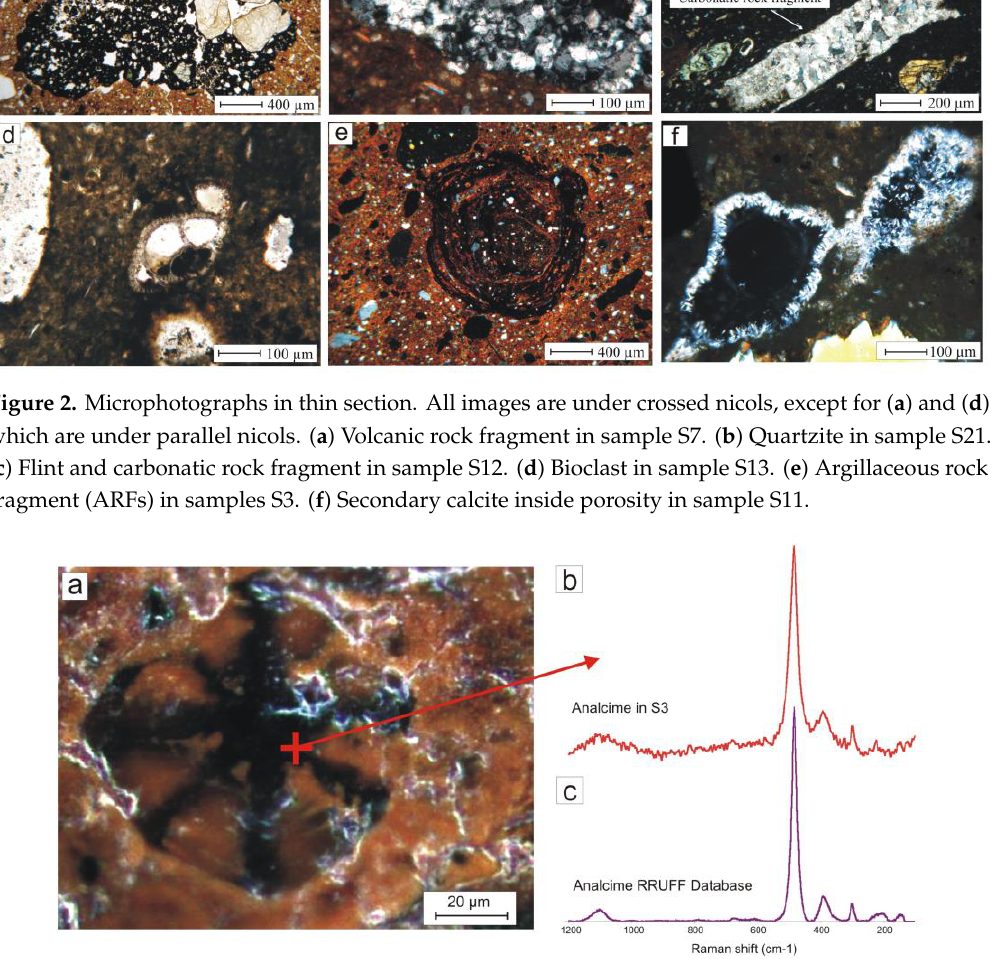
Figure 3. ( a ) OM image under reflected light of a dendritic-skeletal crystal of analcime inside a volcanic rock fragment in sample S3, showing the area analyzed by Raman spectroscopy. ( b ) Raman spectrum of the area analyzed. ( c ) Raman spectrum of the analcime from the RRUFF project database.